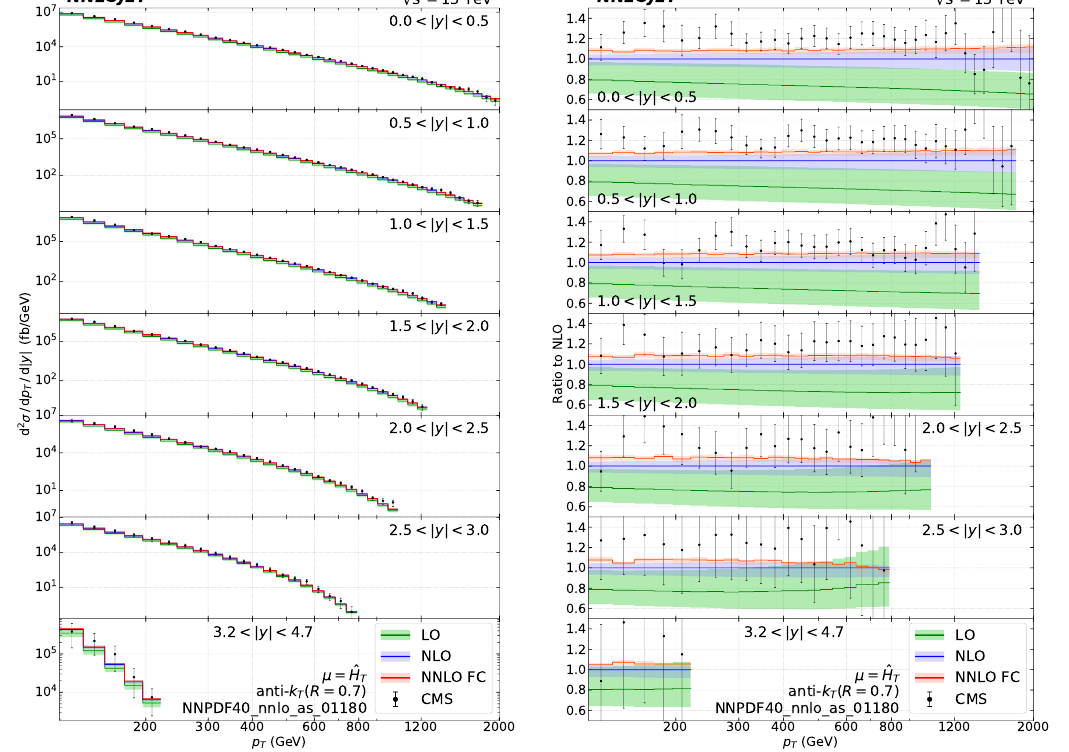
Figure 3 . Double differential single jet inclusive cross sections as function of the jet p T for all rapidity slices with R = 0 . 7 anti- k T jets (left), and normalized to the NLO result (right). Predictions are compared to CMS data